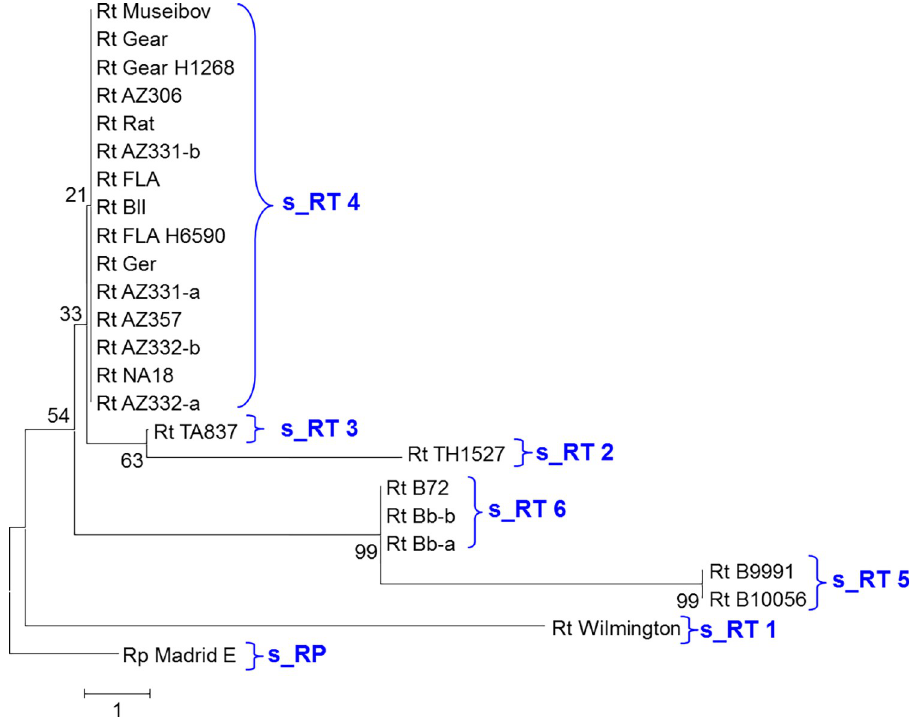
Fig 1. Neighbor joining tree analysis of the variant genetic sites found in isolates of R . typhi . Clades derived from 22 SNP sites.